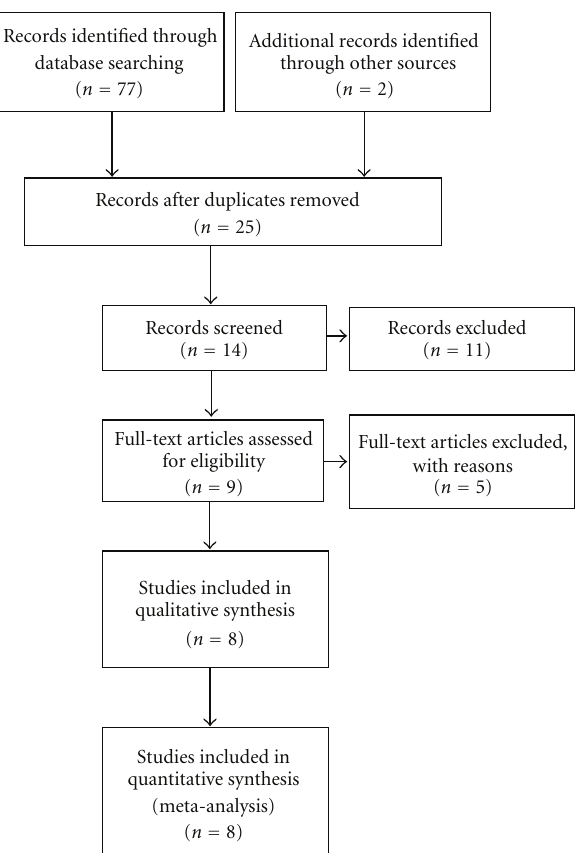
Figure 1: Selection of studies for inclusion in the present